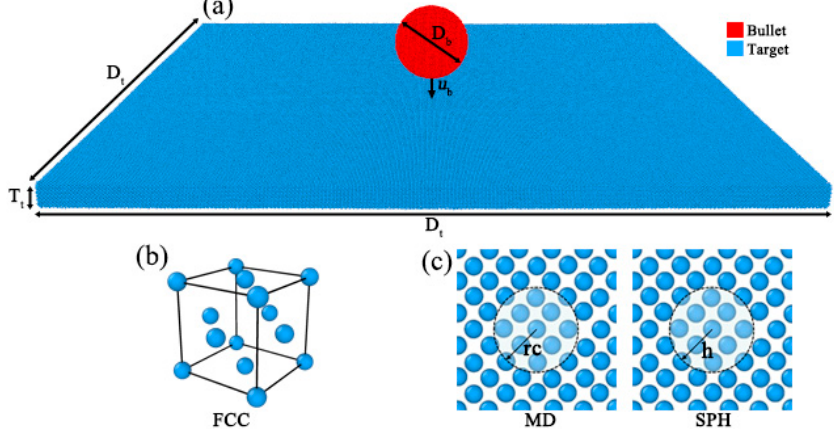
Figure 2. Particle configuration of MD and SPH. ( a ) The spherical bullet with diameter of D b is located at the center of target. The total particle number and bullet-target size ratio between MD and SPH models are the same. ( b ) Both methods are face-centered cubic (FCC) structure. ( c ) The cut-off radius (rc) and the smooth core radius (h) represent maximum range of inter-particle force in MD and SPH, respectively.